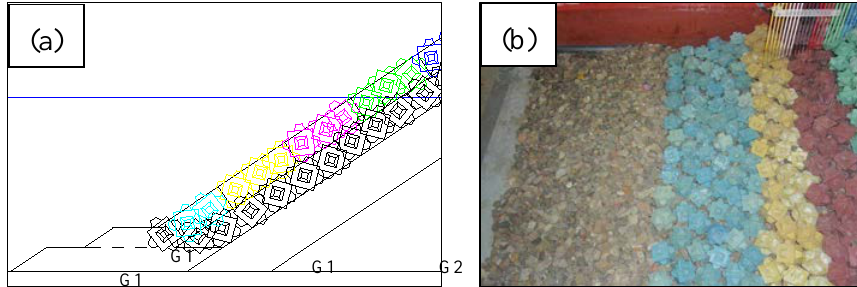
Figure 4. Toe berm used in the experiments: ( a ) Cross-section and ( b ) zenithal view.